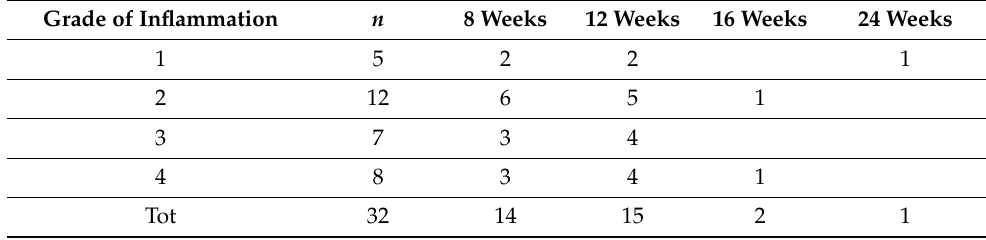
Table 2. Grade of inflammation of appendices and time lapse before interval